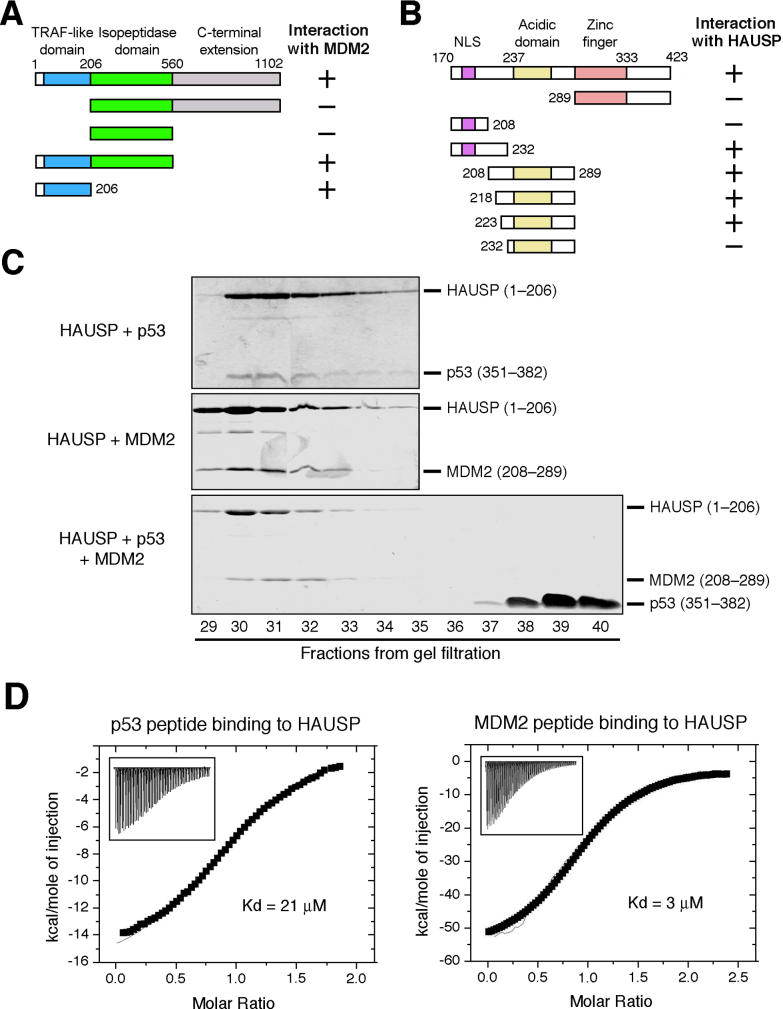
HAUSP Preferentially Forms a Stable HAUSP–MDM2 Complex in the Presence of Excess p53(A) The TRAF-like domain of HAUSP is responsible for binding to MDM2. Various HAUSP fragments were individually incubated with MDM2 protein (residues 170–423) and their interactions were examined by gel filtration. The results are summarized here.(B) Identification of a minimal HAUSP-binding element in MDM2. Various MDM2 fragments were individually incubated with HAUSP TRAF-like domain (residues 53–206) and their interactions were examined by gel filtration. The results are summarized here.(C) HAUSP preferentially forms a stable HAUSP–MDM2 complex in the presence of excess p53. HAUSP (residues 1–206) interacts with both p53 (residues 351–382, upper panel) and MDM2 (residues 208–289, middle panel). However, in the presence of a 10-fold excess amount of p53, HAUSP formed a stable complex only with MDM2 (lower panel). The relevant peak fractions were visualized by SDS-PAGE followed by Coomassie staining.(D) Determination of binding affinities between the HAUSP TRAF-like domain (residues 53–206) and peptides derived from p53 and MDM2 by ITC. The p53 and MDM2 peptides contain residues 351–382 and 208–242, respectively. The binding affinities for the p53 and MDM2 peptides are 3 and 21 μM, respectively.